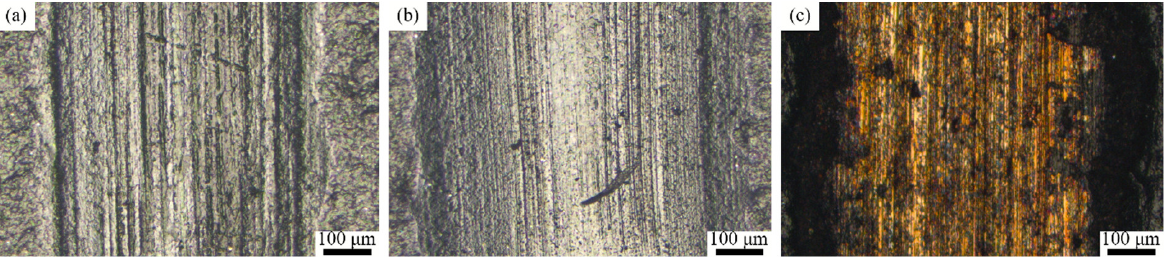
Figure 11. Wear marks of the composite coating under seawater corrosion. ( a ) T1.5 coating; ( b ) T2 coating; ( c ) T2.5coating.